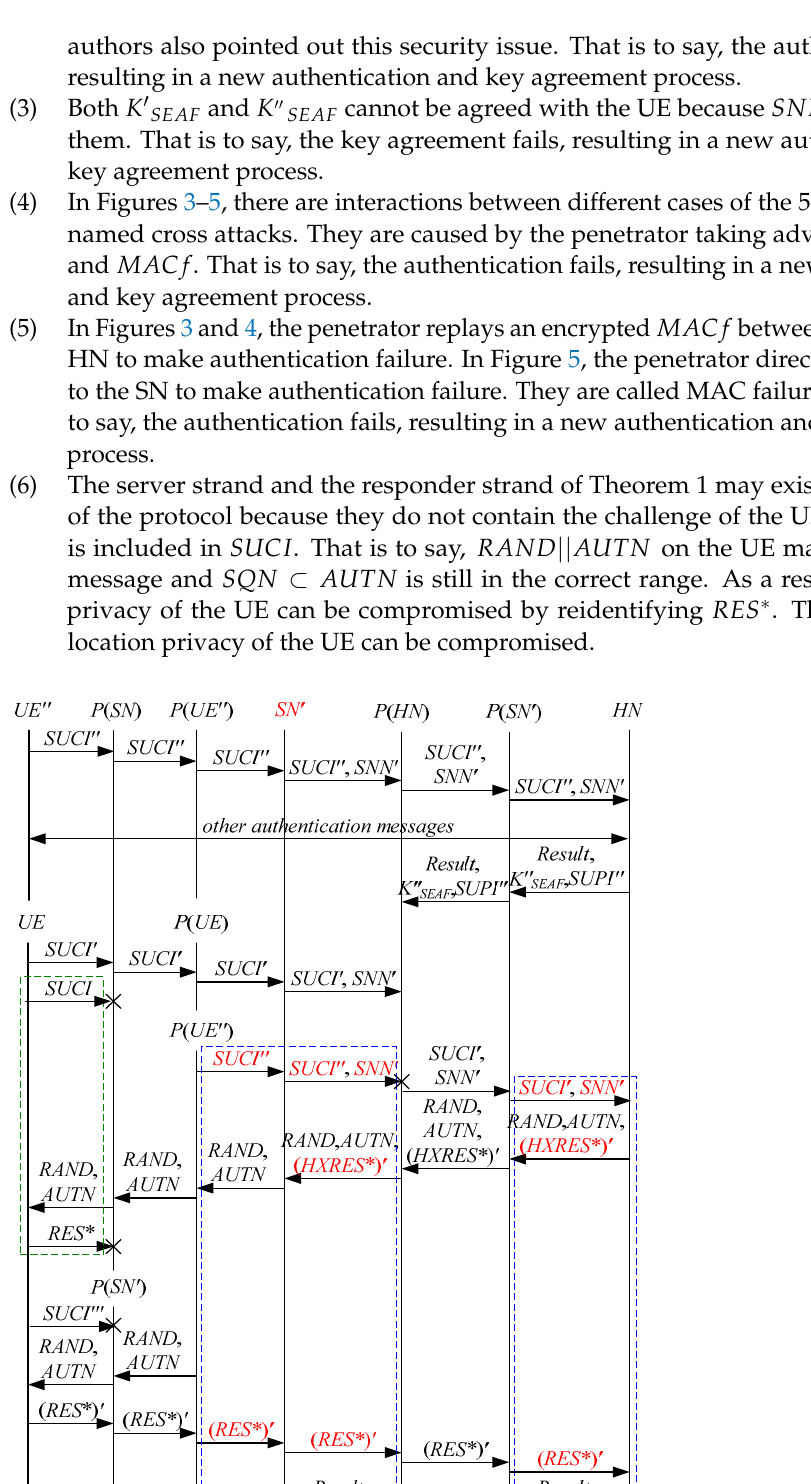
Figure 3. The second attack scenario of the 5G AKA protocol.